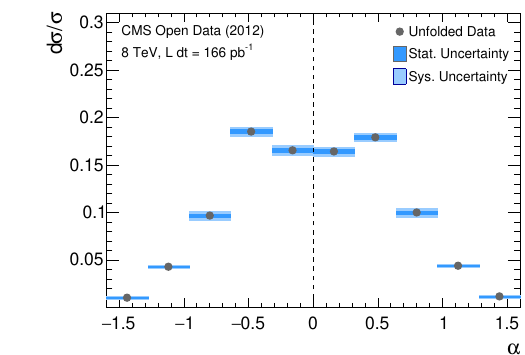
Figure 8 . Unfolded, detector-corrected (cid:11) dis- tribution with statistical and systematic uncer- tainties. For a conservative interpretation, the uncertainties should treated as